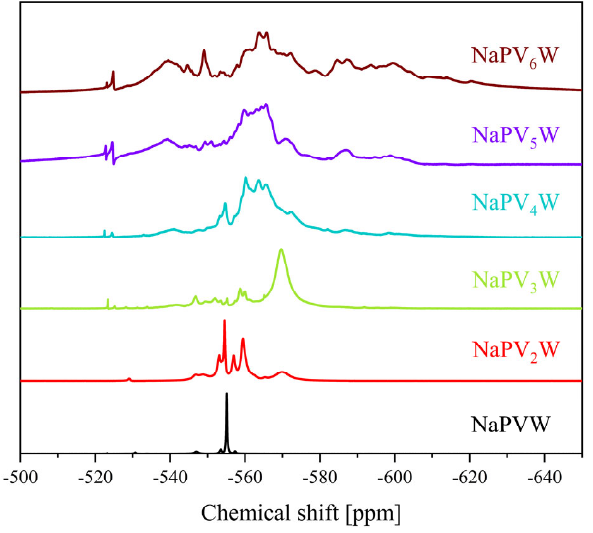
Figure 7. 51 V-NMR spectra of the POMs NaPV x W, with x = 1 to 6. All spectra were measured in a mixture of 70% water (pH 1) and 30% D 2 O. Measurement frequency: 157.8 MHz; NaVO 3 was used as an external standard. All peaks for the V(V)-substituted POMs, appear in the 31 P-NMR spectra in the range between − 5 and − 2 ppm for HPV x Mo, and in the range between − 15 and − 6 ppm for